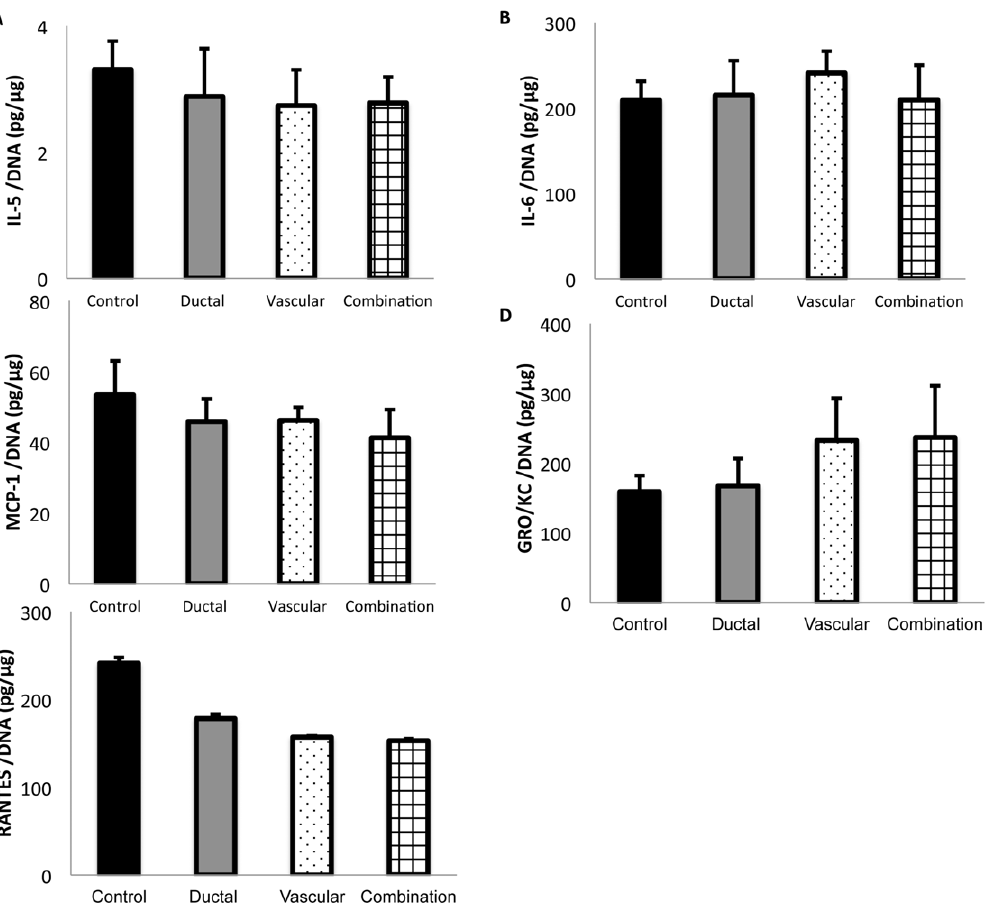
Figure 7. The effects of ductal injection and/or vascular perfusion on the release of inflammatory mediators. The inflammatory mediators released from 50 islets isolated from the pancreases subjected to 10 h cold ischemia and 30 min warm ischemia were cultured for 72 h and then examined (n=8). IL-5 (A), IL-6 (B), MCP-1 (C), GRO/KC (D), and RANTES (E) could be detected in all samples. The data show the means 6 SE. No significant differences were detected among the